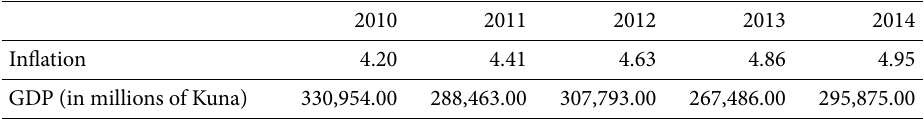
table 5. The scenario of increasing inflation impact on GDp